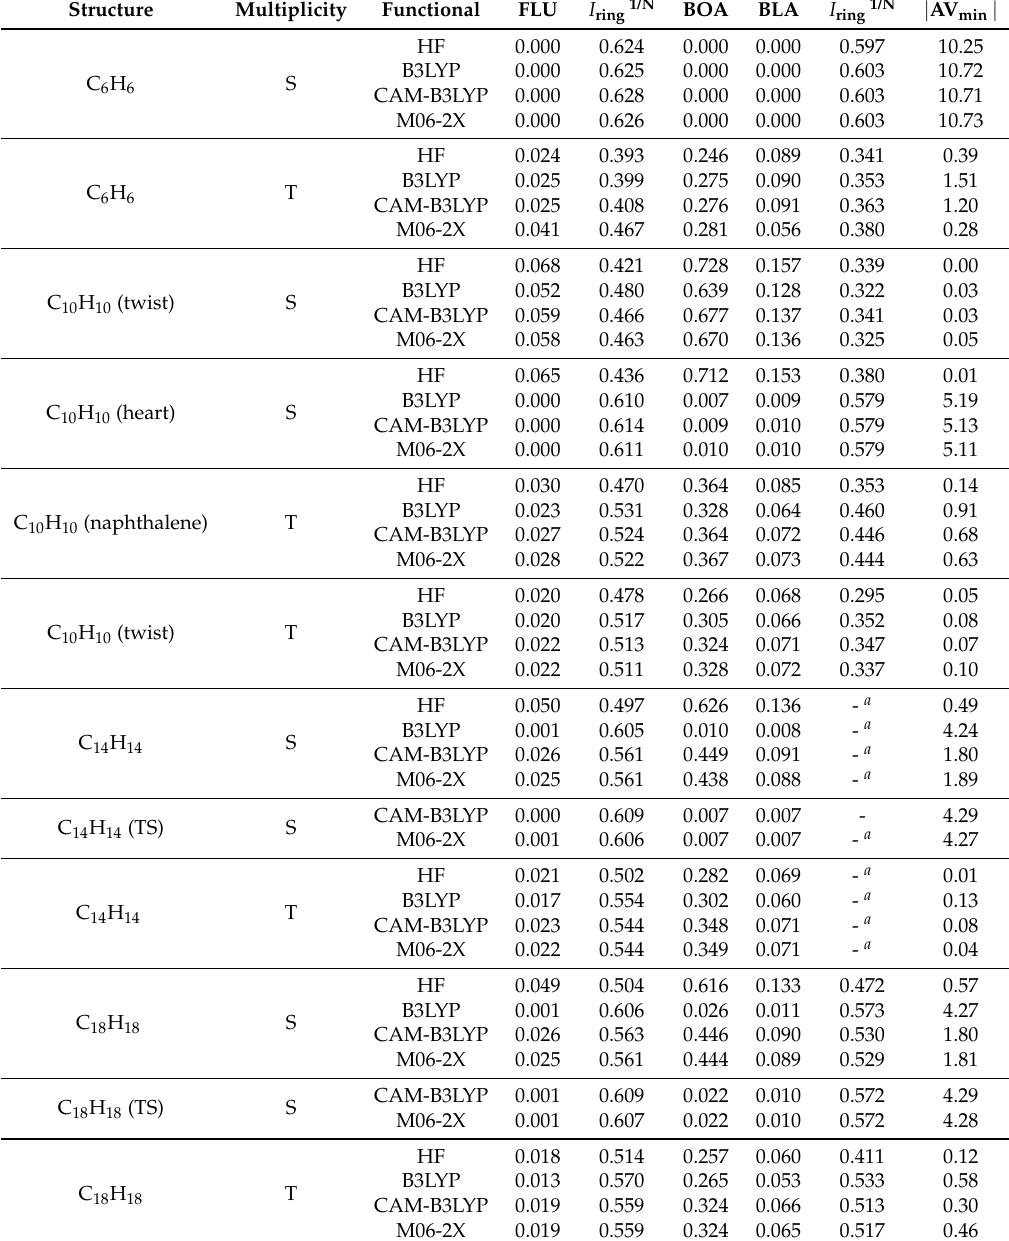
Table 1. Aromaticity indices for 4 n + 2 annulenes calculated with HF, B3LYP, CAM-B3LYP, and M06-2X and the 6-311G(d,p) basis set. a I ring values were too small for an accurate calculation of I ring 1/N .